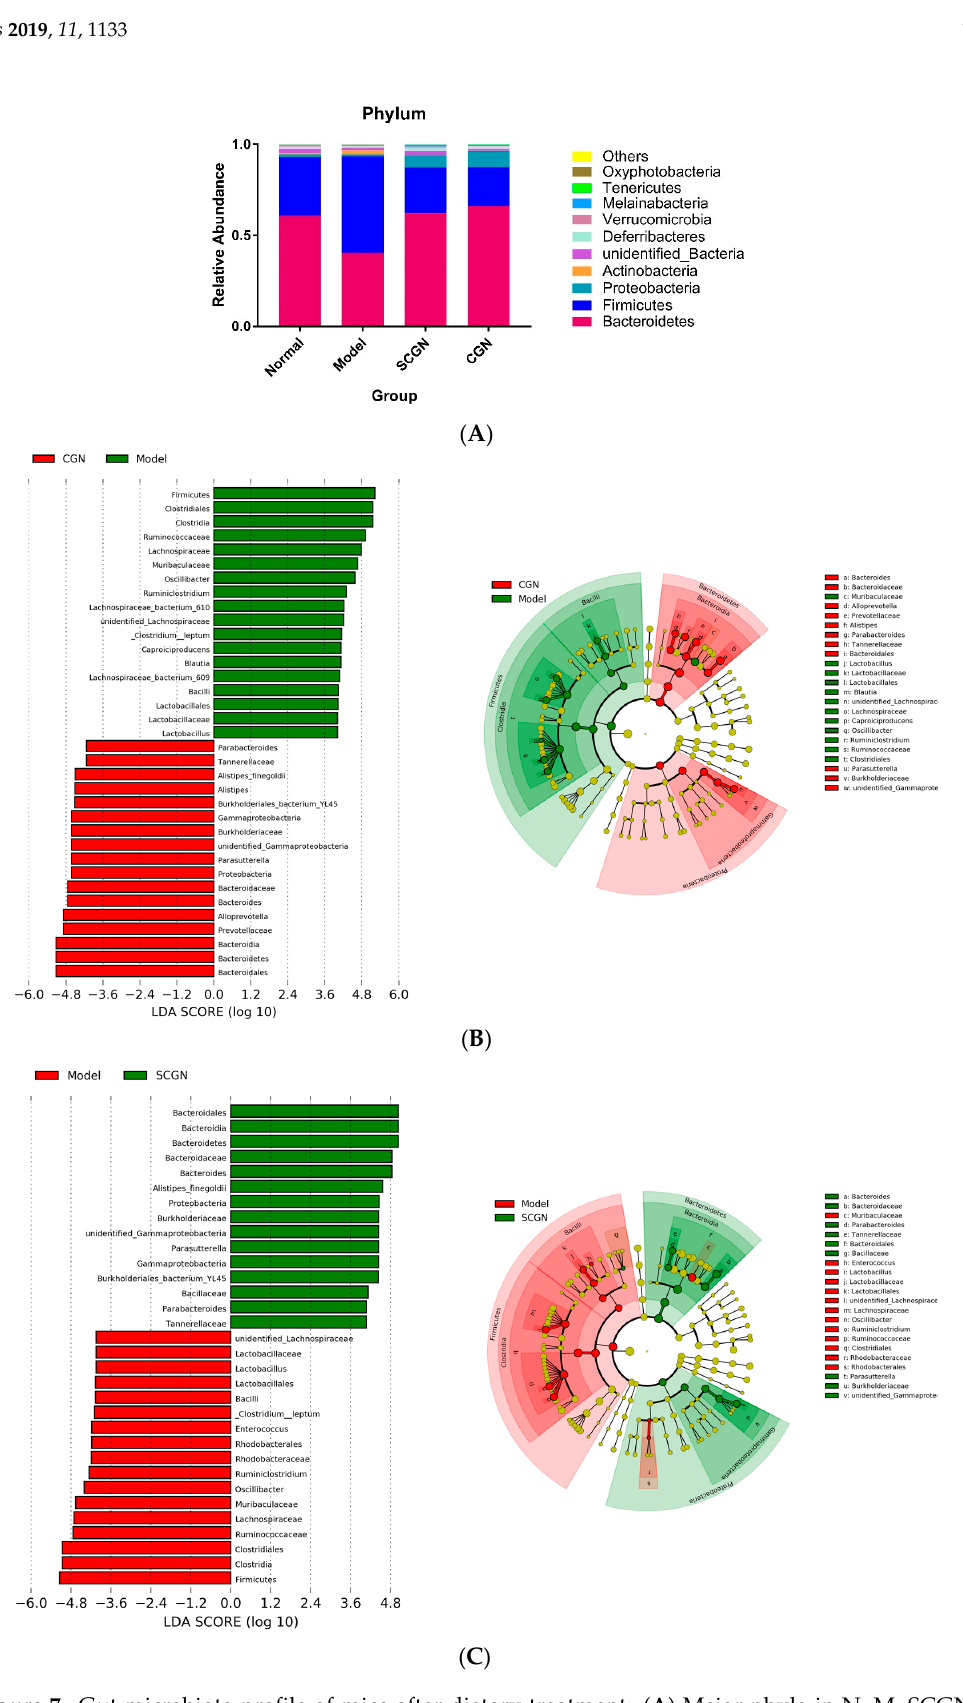
Figure 7. Gut microbiota profile of mice after dietary treatment: ( A ) Major phyla in N, M, SCGN, and CGN, ( B ) LEfSe analysis of CGN versus M, and ( C ) LEfSe analysis of SCGN versus M. N = Normal, M = Model, SCGN = Sans-carrageenan fraction, CGN = Carrageenan; n = 5.